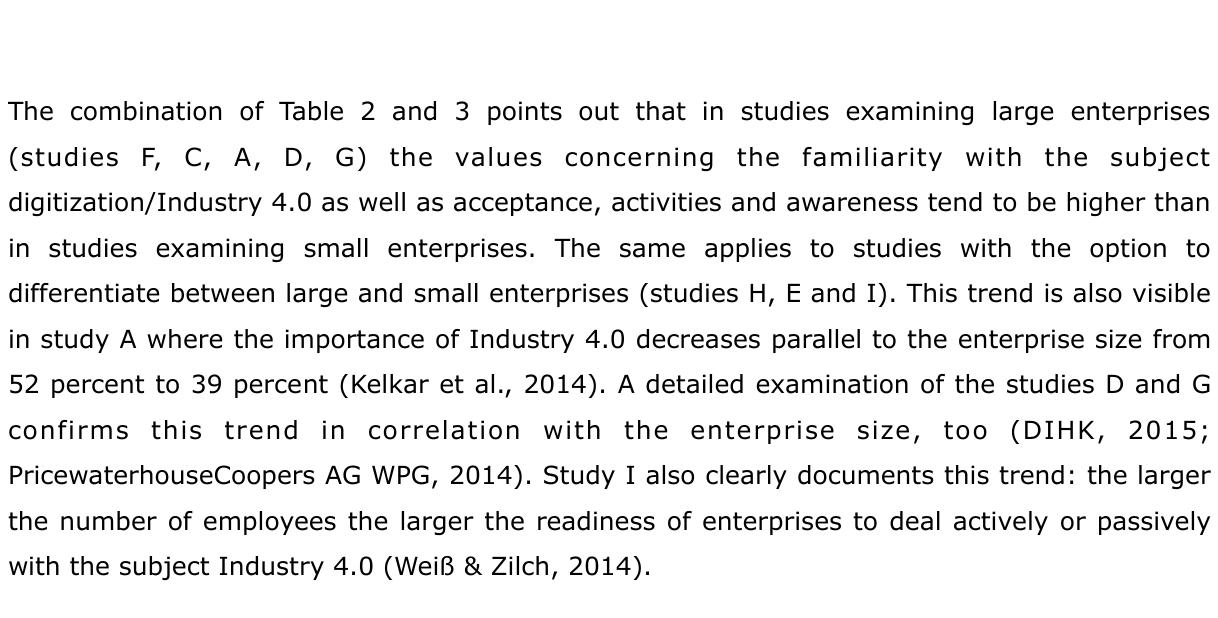
Table 3. Overview of the enterprise sizes examined in the different studies